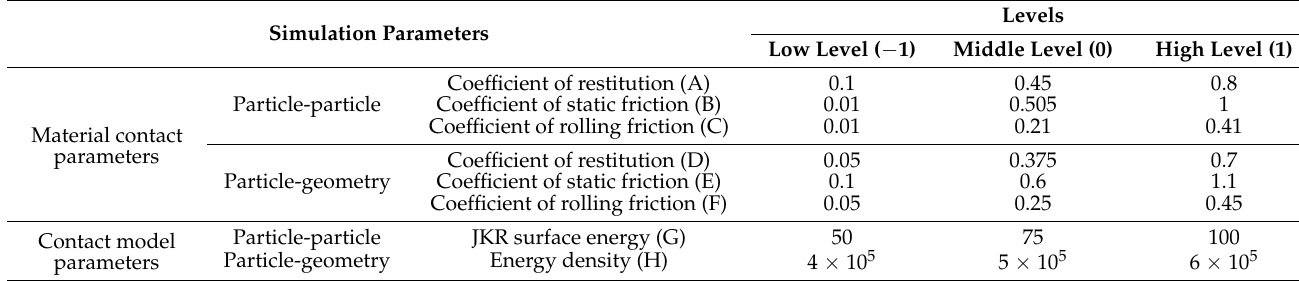
Table 2. The range of simulation